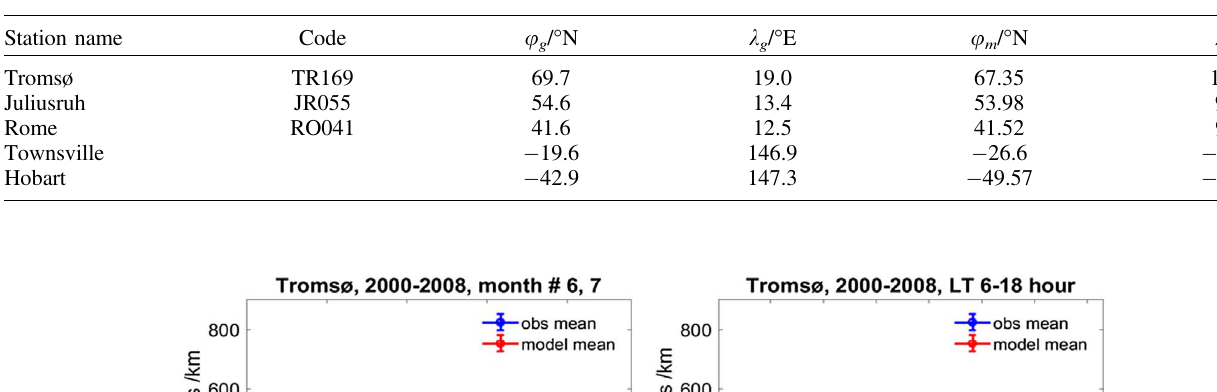
Table 2. List of ionosonde stations used for NSTM